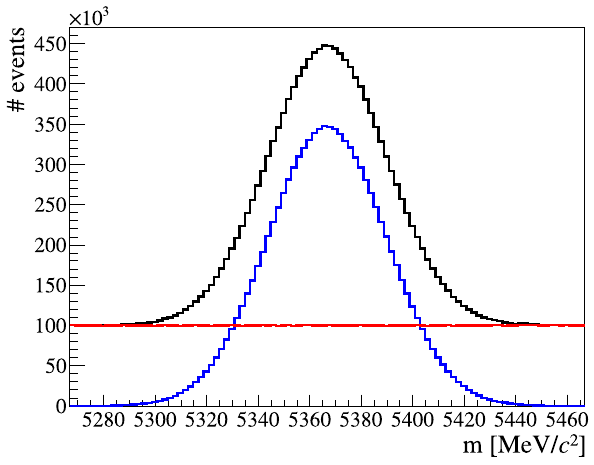
Fig. 12 Discriminating mass distribution for (black) the full data, (blue) signal and (red) background using the mass range [ 5267 , 5467 ] MeV / c 2